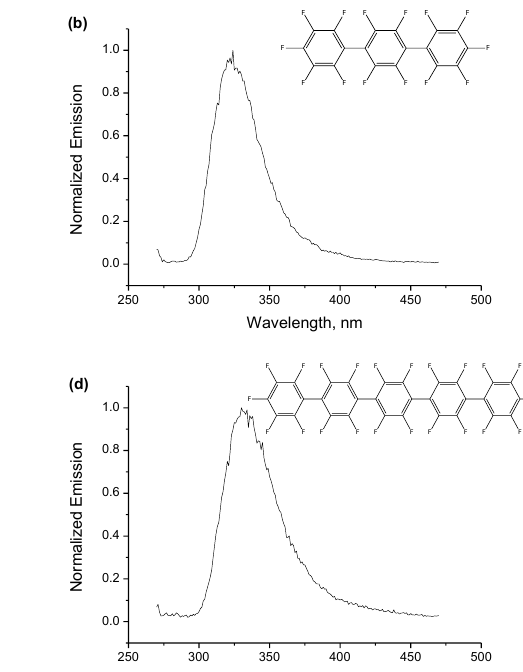
Figure 1. Absorption spectra of the four compounds ( a — 1 , b — 2 , c — 3 , d — 4 ) in acetonitrile at indicated concentrations. Positions of the maxima and molar absorption coefficients at the maxima are collected in Table 1.